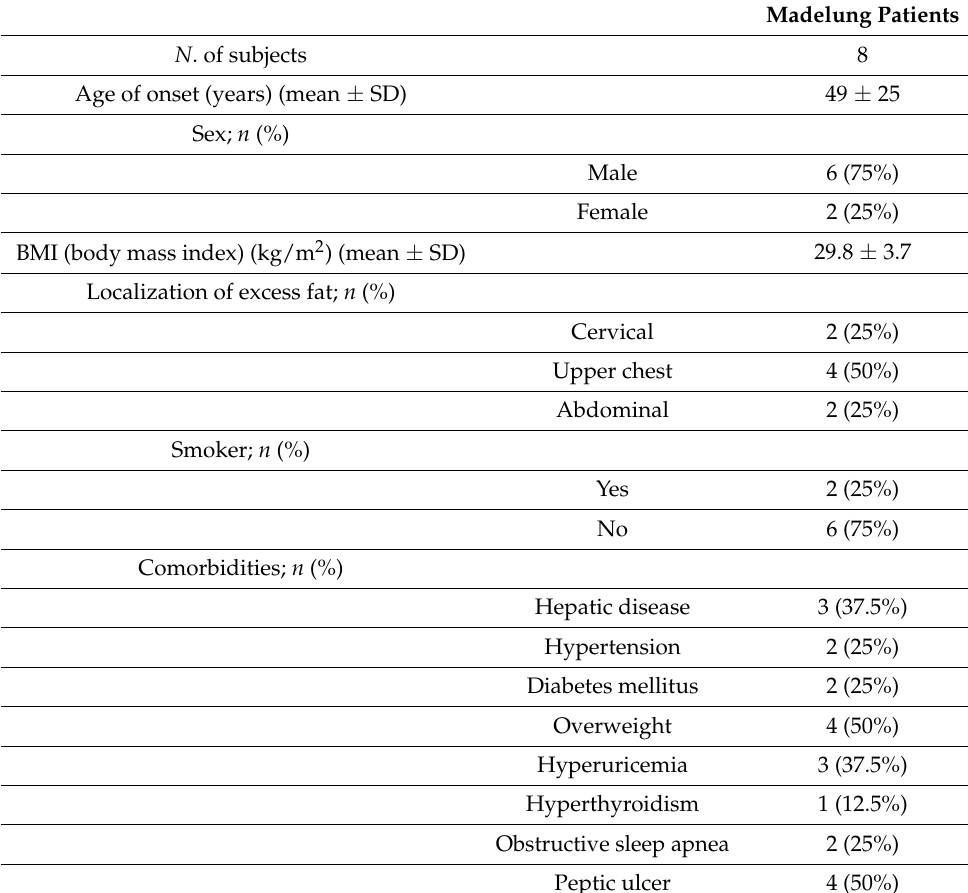
Table 1. Madelung disease (MD) patient